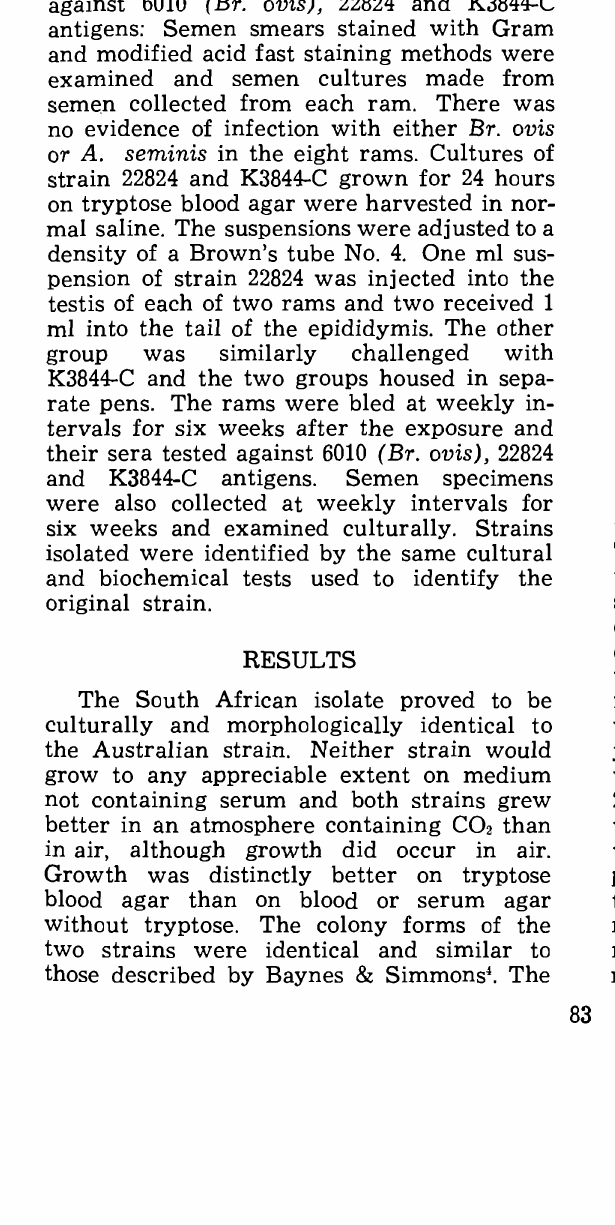
TABLE 1: COMPLEMENT FIXATION TITRES